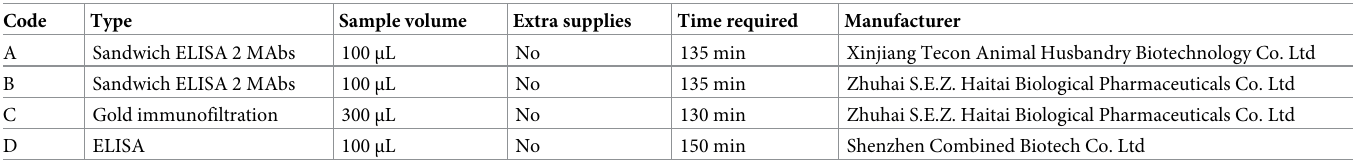
Table 1. Major features of the assessed tests for Echinococcus granulosus diagnosis in dogs.